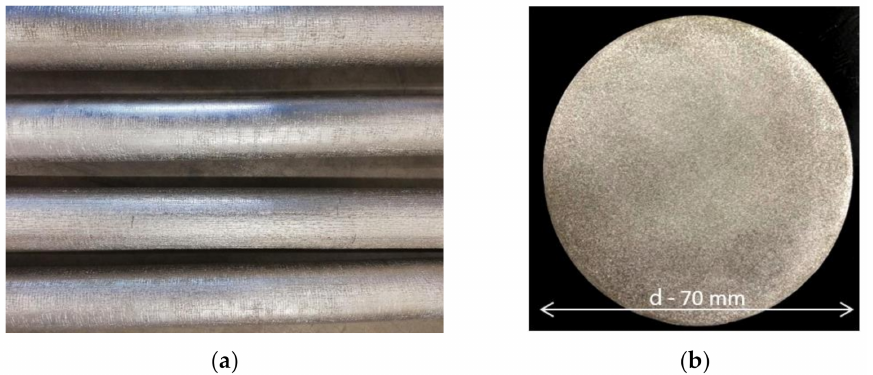
Figure 5. Outer surface of the obtained ingots ( a ) and a typical macrostructure on the ingot cross section ( b